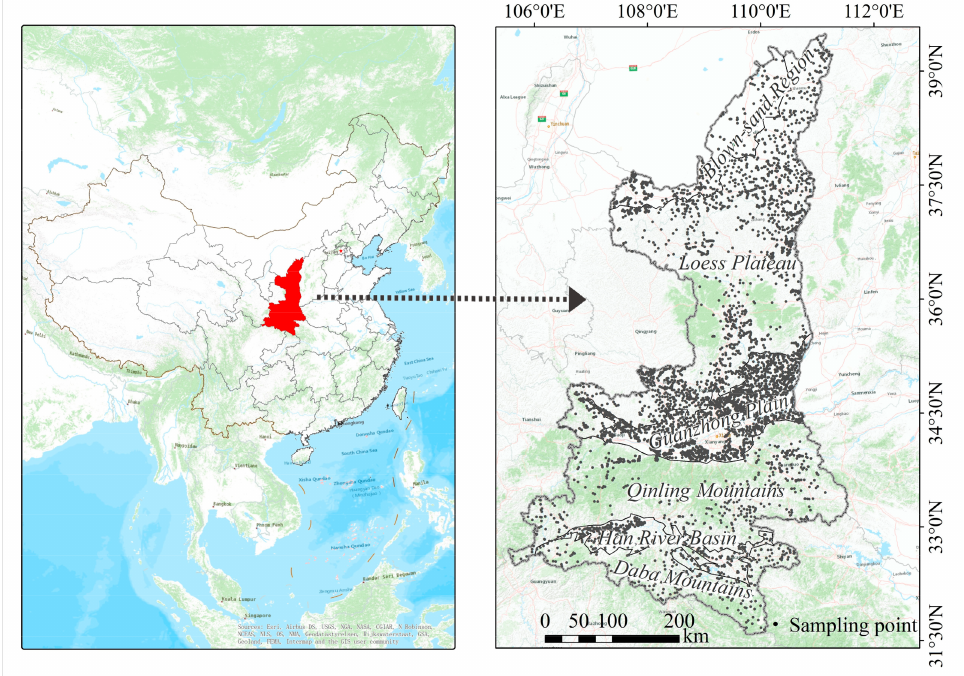
Figure 1. Study area and soil sample sites in Shaanxi Provence, China (n =